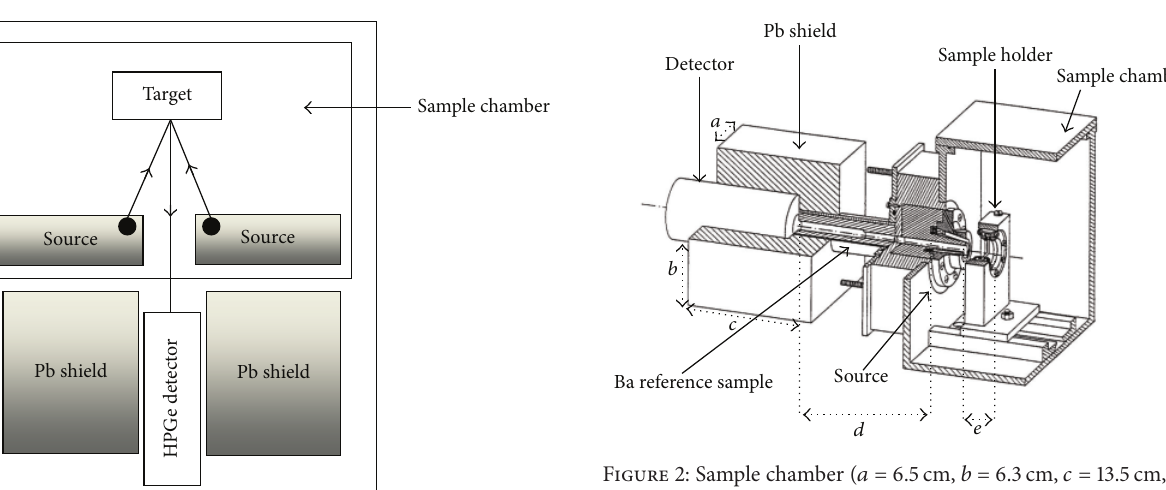
Figure 2: Sample chamber ( 𝑎 = 6.5 cm, 𝑏 = 6.3 cm, 𝑐 = 13.5 cm, 𝑑 = 11cm, 𝑒 = 5 cm).